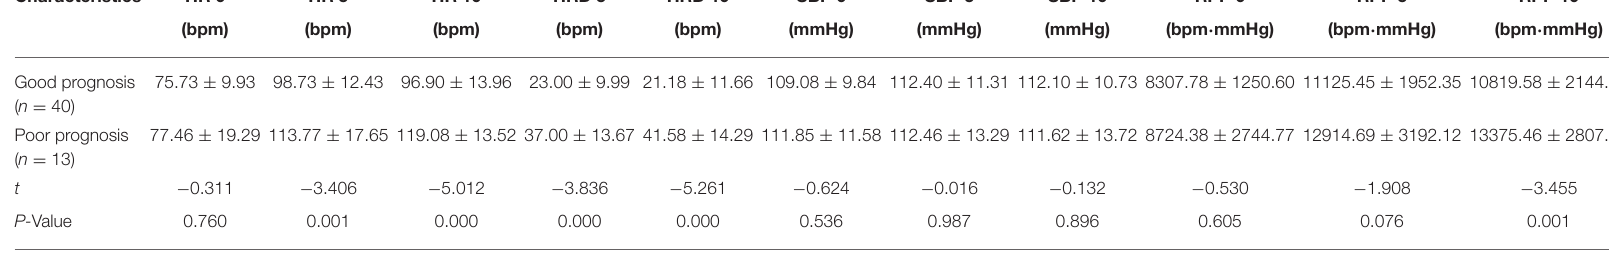
TABLE 4 | Comparison of HUTT parameters for good prognosis group and poor prognosis group (Mean ± SD). Characteristics